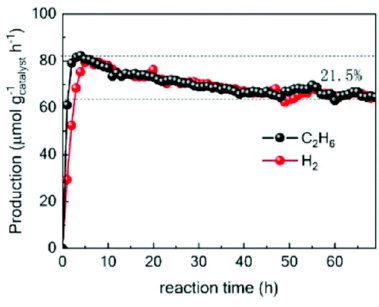
Figure 47. Time course of the production rate of ethane and H 2 . Reproduced from [28] with permission from The Royal Society of Chemistry.